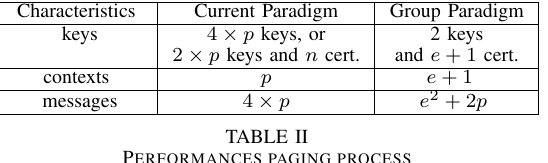
TABLE II P ERFORMANCES PAGING PROCESS